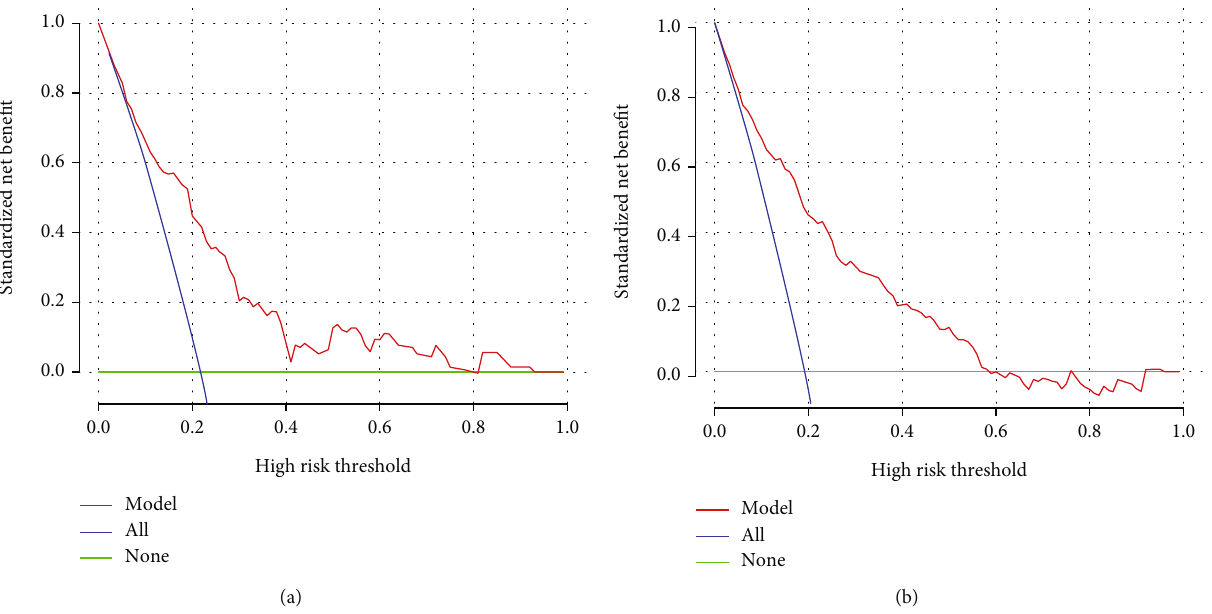
Figure 6: Evaluation of clinical validity of predictive models on the data of the training set (a) and validation set